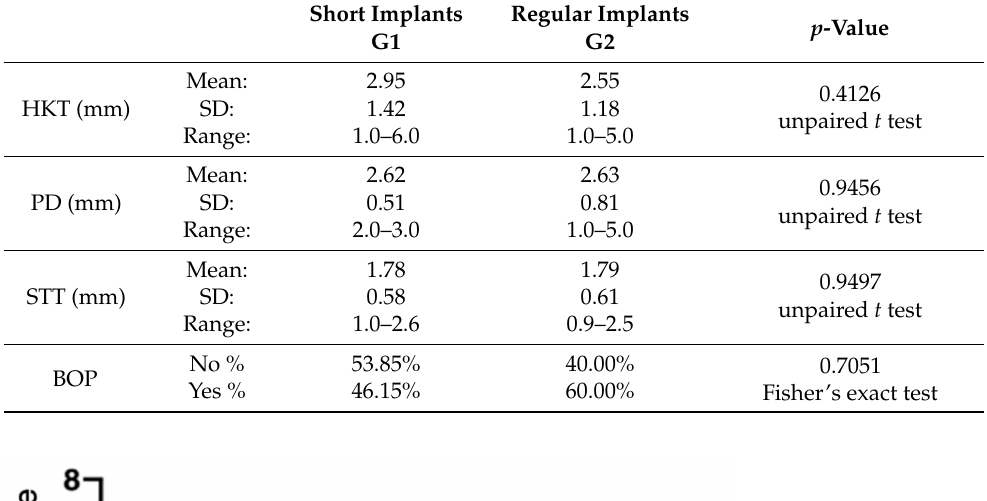
Table 2. Clinical outcome measures.